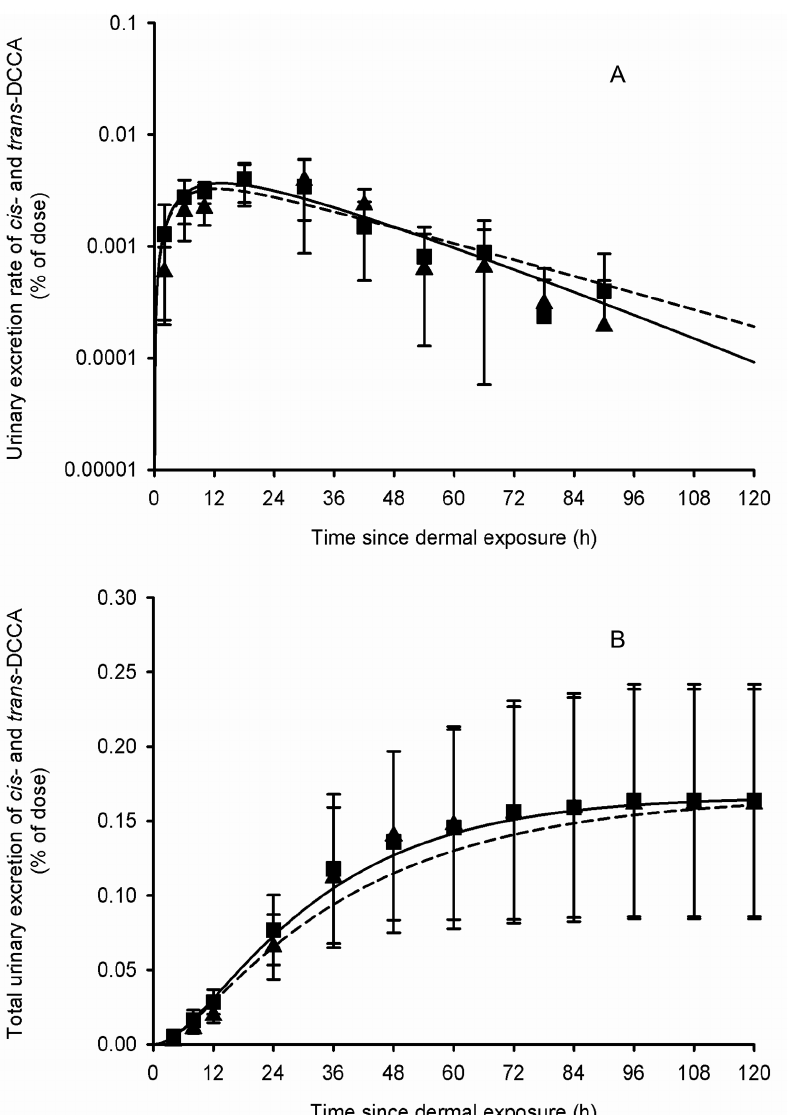
Figure 5. Comparison of model simulations with experimental data for cis - and trans -DCCA (volunteers dermally exposed). Comparison of model simulations (lines) with experimental data of Woollen et al. (1992) (symbols) on the average time courses of cis - and trans-DCCA excretion rate (A) and cumulative excretion (B) (% of applied dose) in volunteers dermally exposed to 31 mg of cypermethrin. Triangle and square symbols represent average experimental values for cis - and trans -DCCA, respectively, and vertical bars the experimental standard deviation